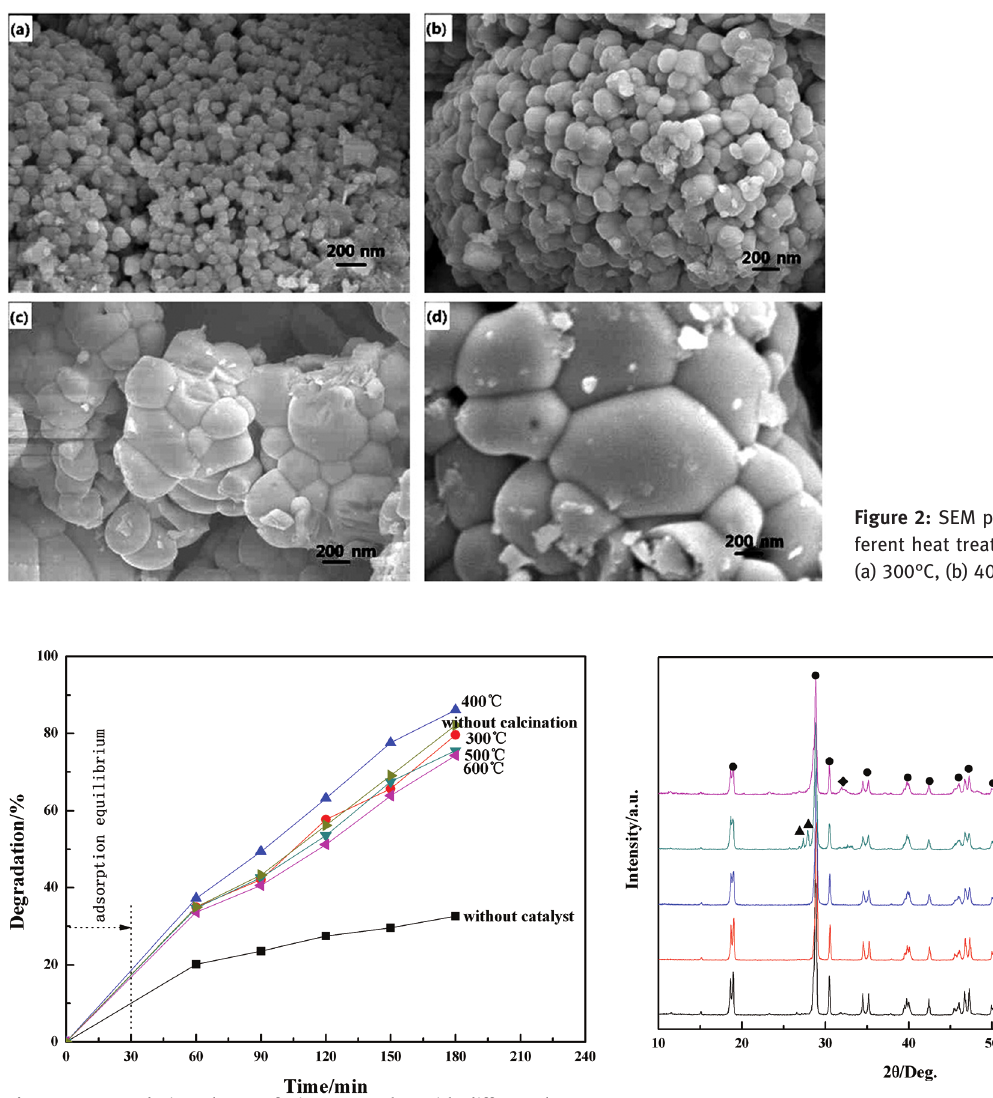
Figure 4: XRD patterns of BiVO 4 with different heat treatment time at 400 ℃